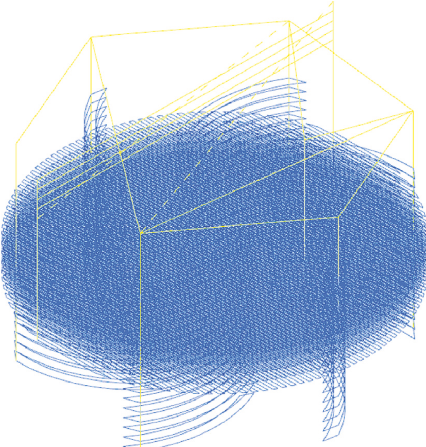
Figure 28: Toolpath for integrated substrate build strategy.